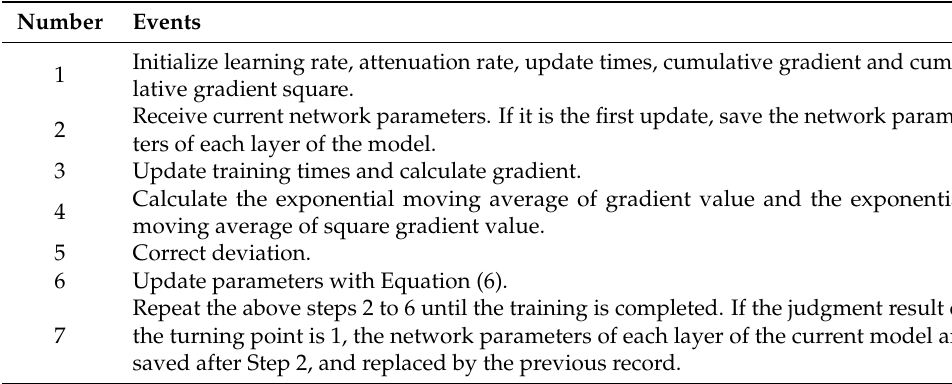
Table 2. The main steps in the optimizer.